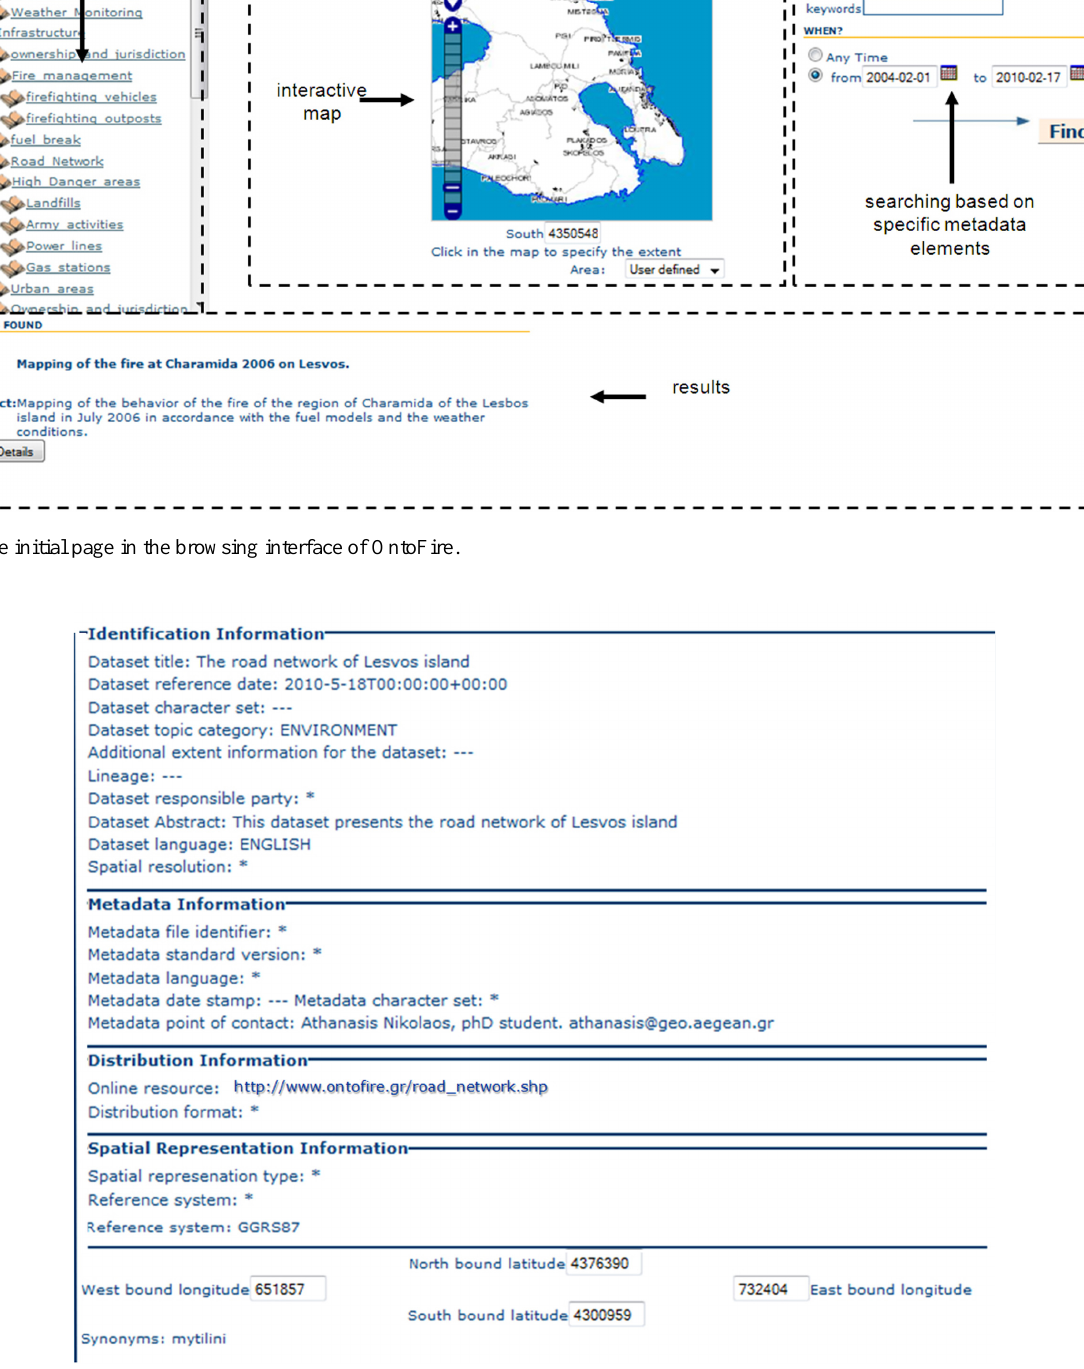
Fig. 6. Detailed metadata description of a resource in